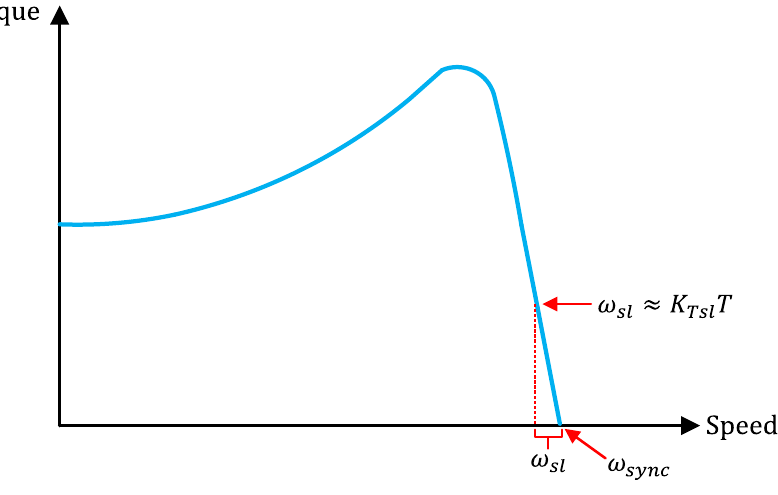
Figure 5. Torque – speed curve of an induction motor. Figure 5. Torque–speed curve of an induction